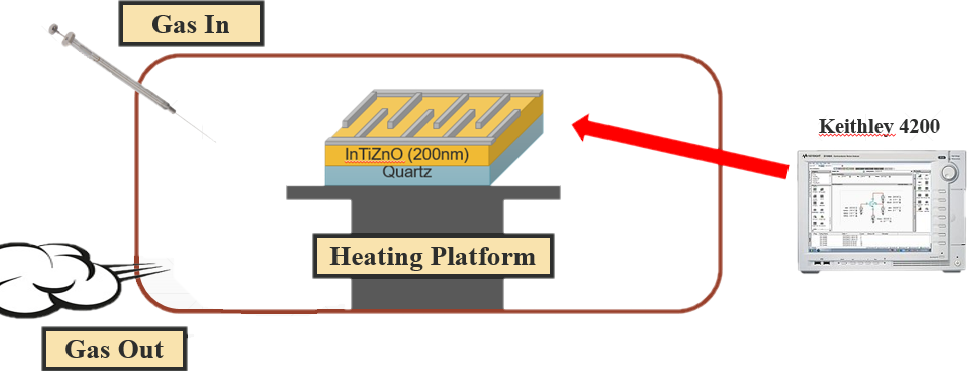
Figure 1. MSM structure of InTiZnO gas sensor and the measurement environment of the gas sensor.